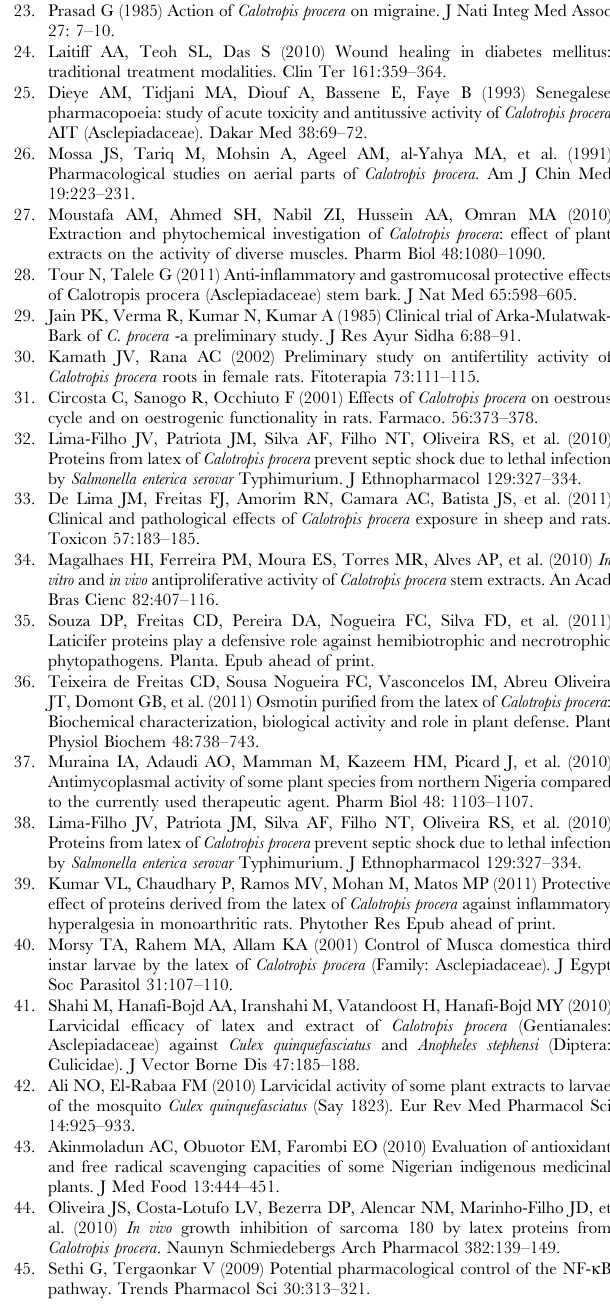
Table S1 Detailed methodology for the supplementary materials of the amino acid sequence of the apolipoprotein A-I to which CP- P has been matched. A peptide summary report and clearer picture of MS/MS by mascot search